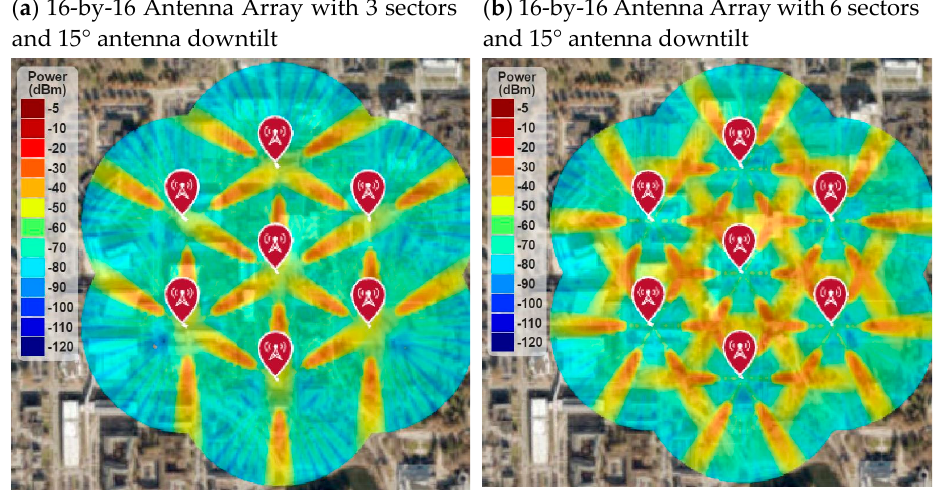
Figure 21. RF coverage and signal strength versus higher-order sectorization.